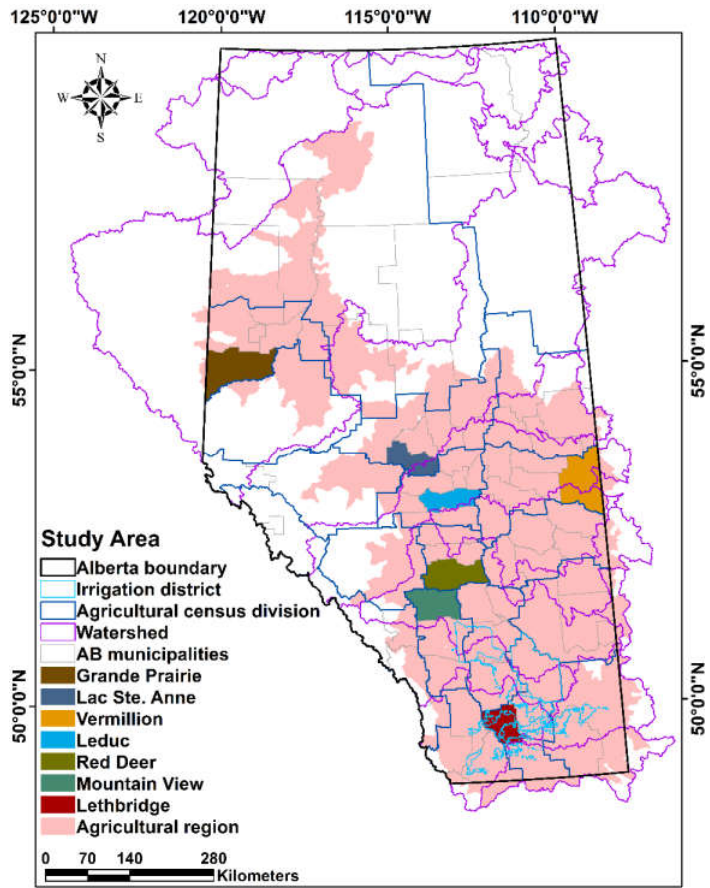
Figure 1. Map of the study area (agricultural region) overlaid with the Alberta boundary, watersheds, agricultural census divisions, Alberta municipalities and irrigation districts of Alberta. The seven shaded areas are the location of case study for trend analysis.